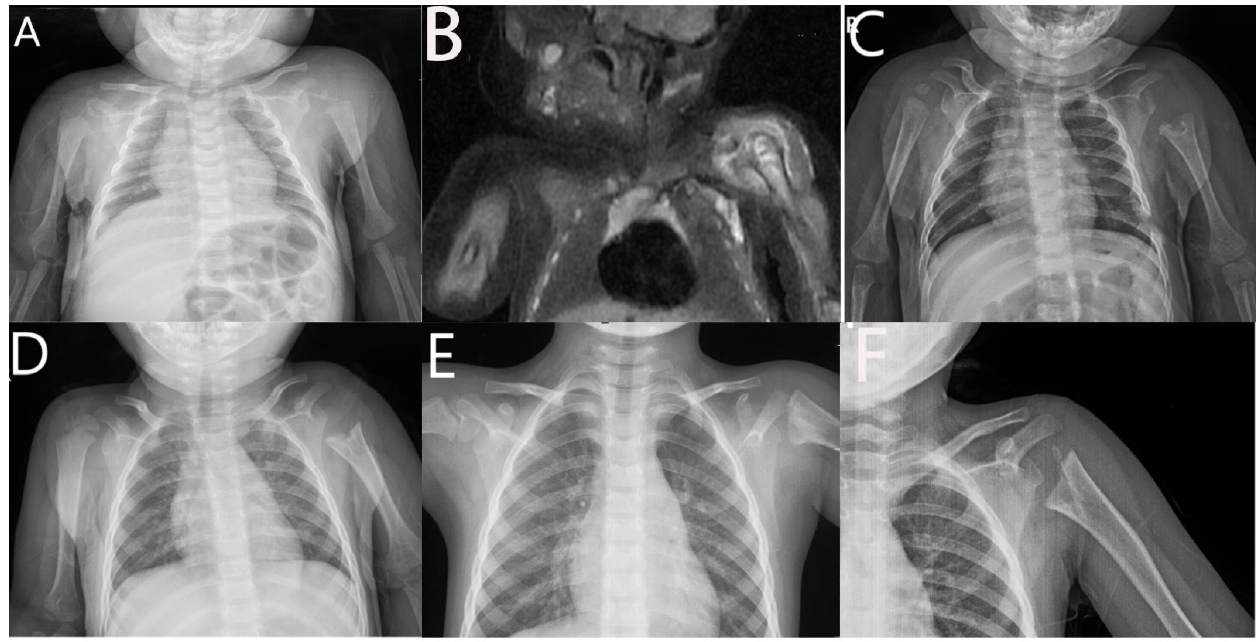
Figure 2. Left humeral epiphyseal osteomyelitis and septic arthritis of 25-d girl. ( A ). AP view X-ray of shoulder joint. ( B ). MR image of shoulder joint. ( C ). AP view X-ray of shoulder joint at 3rd month follow-up. ( D ). AP view X-ray of shoulder joint at 13th month follow-up. ( E ). AP view X-ray of shoulder joint at 3rd year follow-up. ( F ). AP view X-ray of shoulder joint at 4th year follow-up.